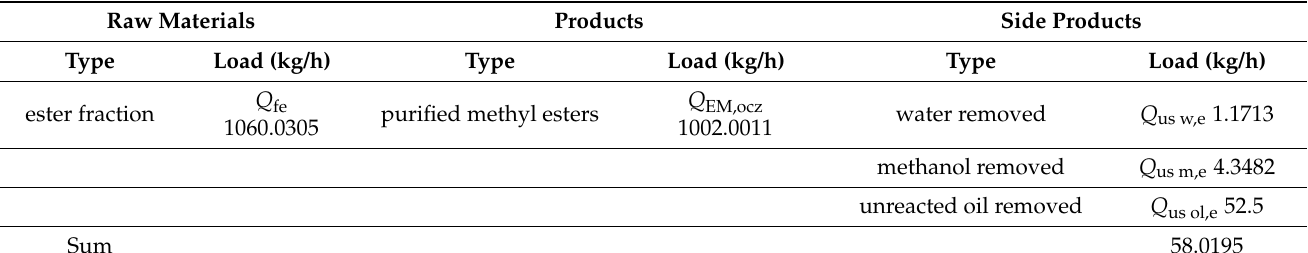
Source: own study based on